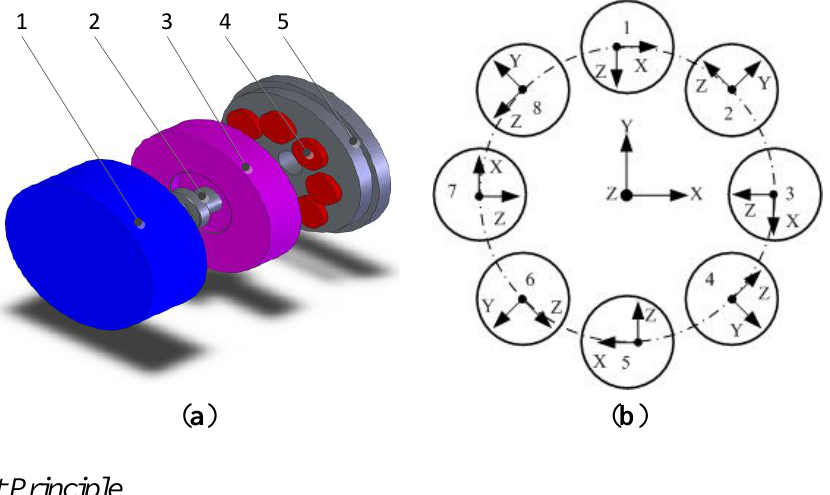
Figure 1. Schematic diagram of the 6-axis accelerometer. ( a ) Exploded view of the six-DOF accelerometer; ( b ) Spacial layout structure schematic of the quartz chip